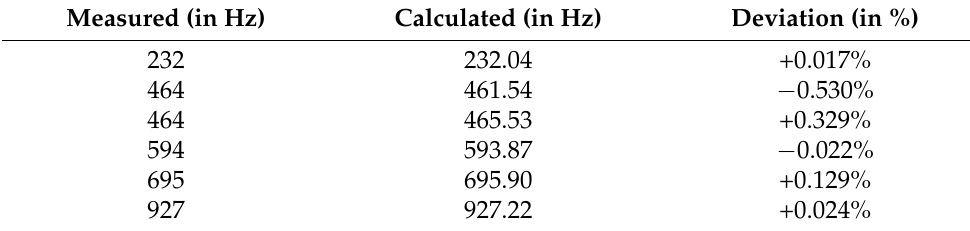
Table 10. Draft tube